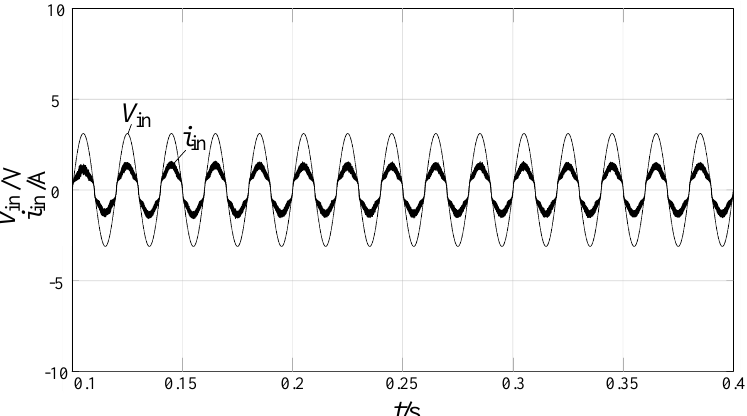
Figure 12. Input voltage and current waveforms of the bridgeless PFC converter with bidirectional buck/boost converter.